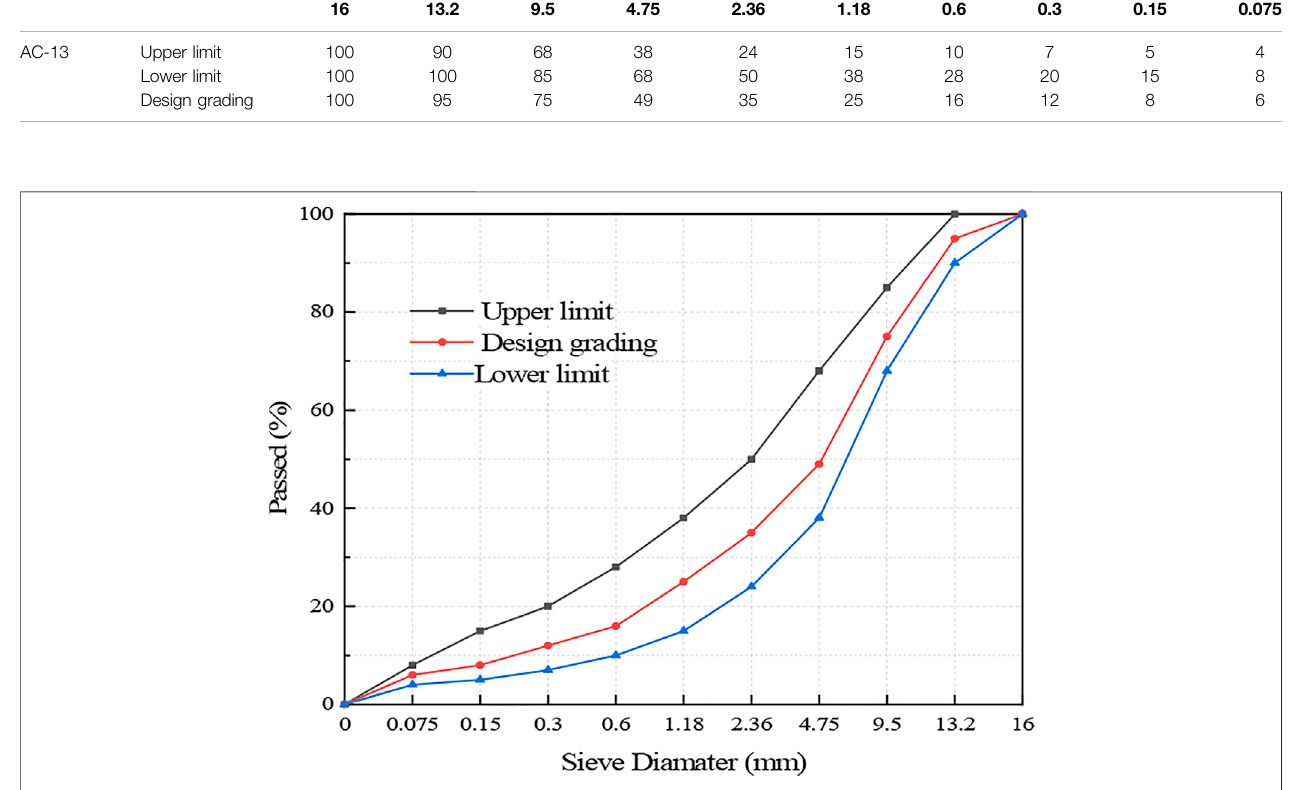
FIGURE 2 | AC-13 asphalt mixture gradation design range.